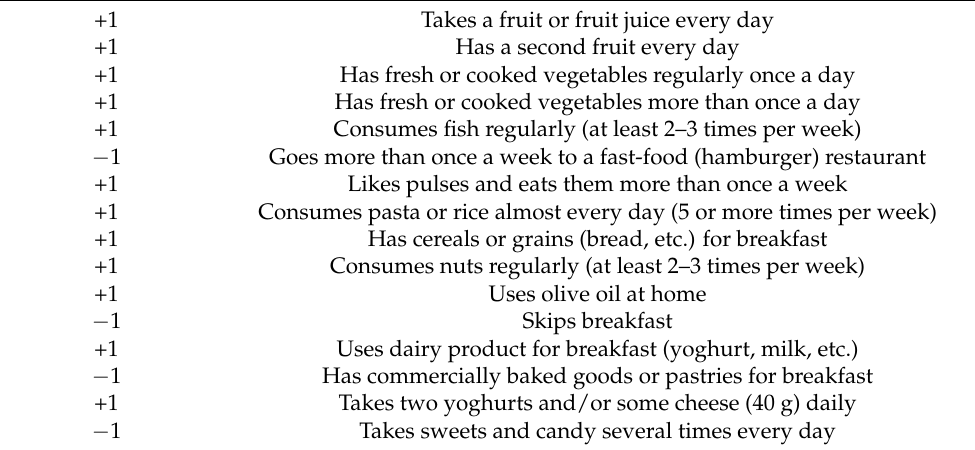
Table 1. KIDMED questionnaire to assess the Mediterranean diet (MD) quality.